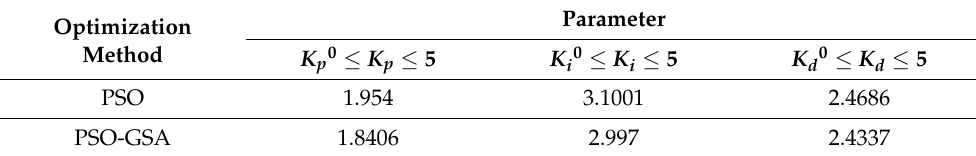
Table 4. Optimized PID parameter results (PSO and PSO-GSA).